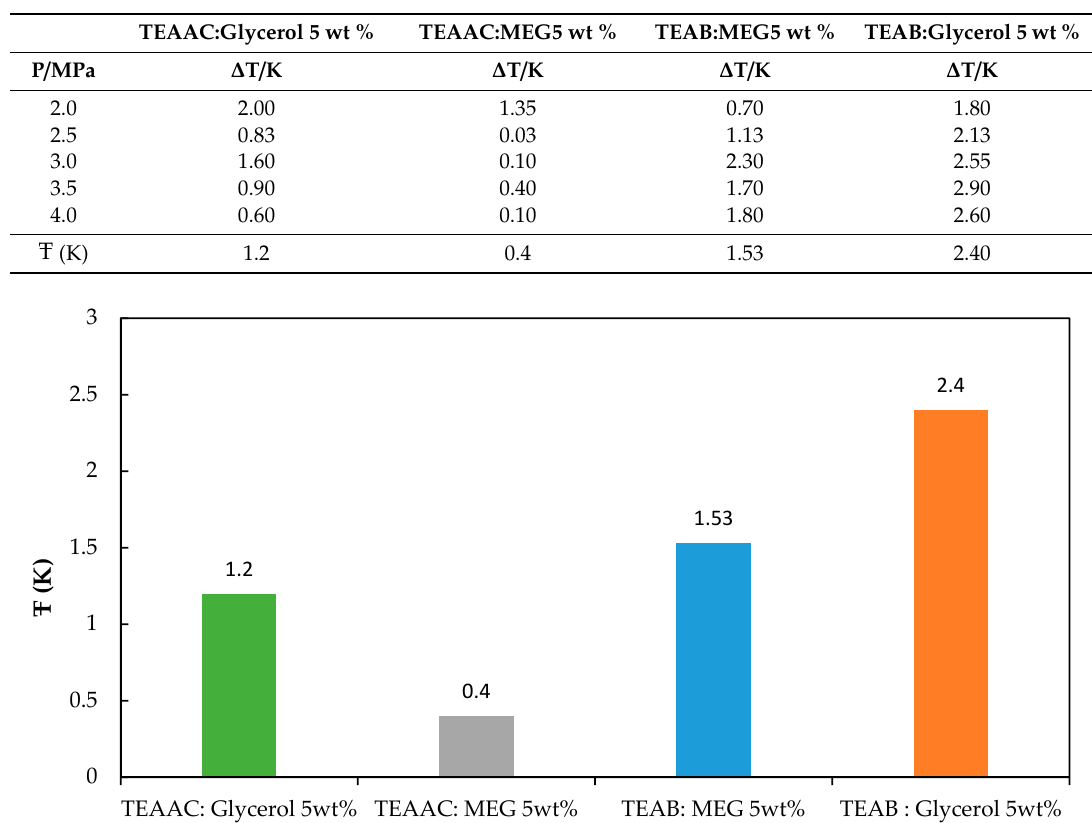
Figure 1. Experimental schematic diagram of rocking cell hydrate reactor [42].